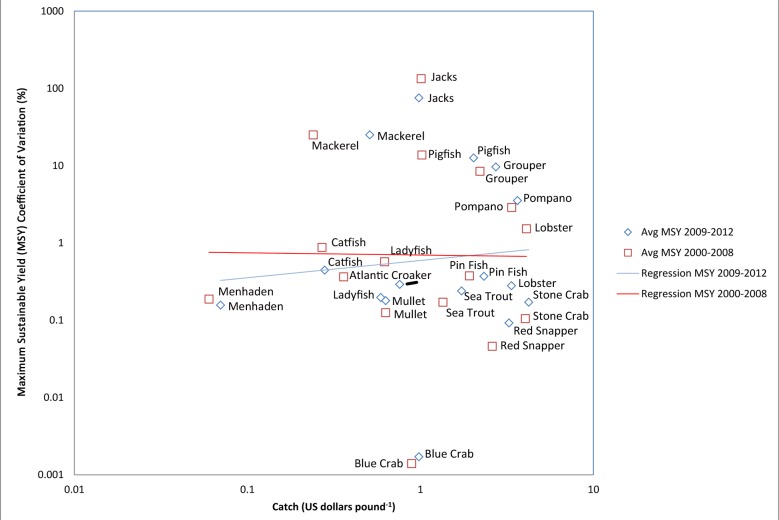
Accuracy of assessment model versus total catch value by functional group.This figure illustrates the discrepancy (coefficient of variation) of Maximum Sustainable Yield (MSY) estimated between the (assessment) Pella-Tomlinson model and (operating) Ecospace model based on 2000 to 2008 data (red squares and regression line) and 2009 to 2012 data (blue diamonds and regression line). Catch values ($ pound-1) per species are detailed by the National Oceanic and Atmospheric Administration (NOAA) online at: http://www.st.nmfs.noaa.gov/pls/webpls/FT_HELP.SPECIES. In general, valuable functional groups (towards the right of the figure) should be assessed by FIM programs with greater rigor and accuracy than other functional groups, particularly Grouper, Jacks, Mackerel, Pigfish, and Pompano. Regression lines are not significantly different from zero or one another.